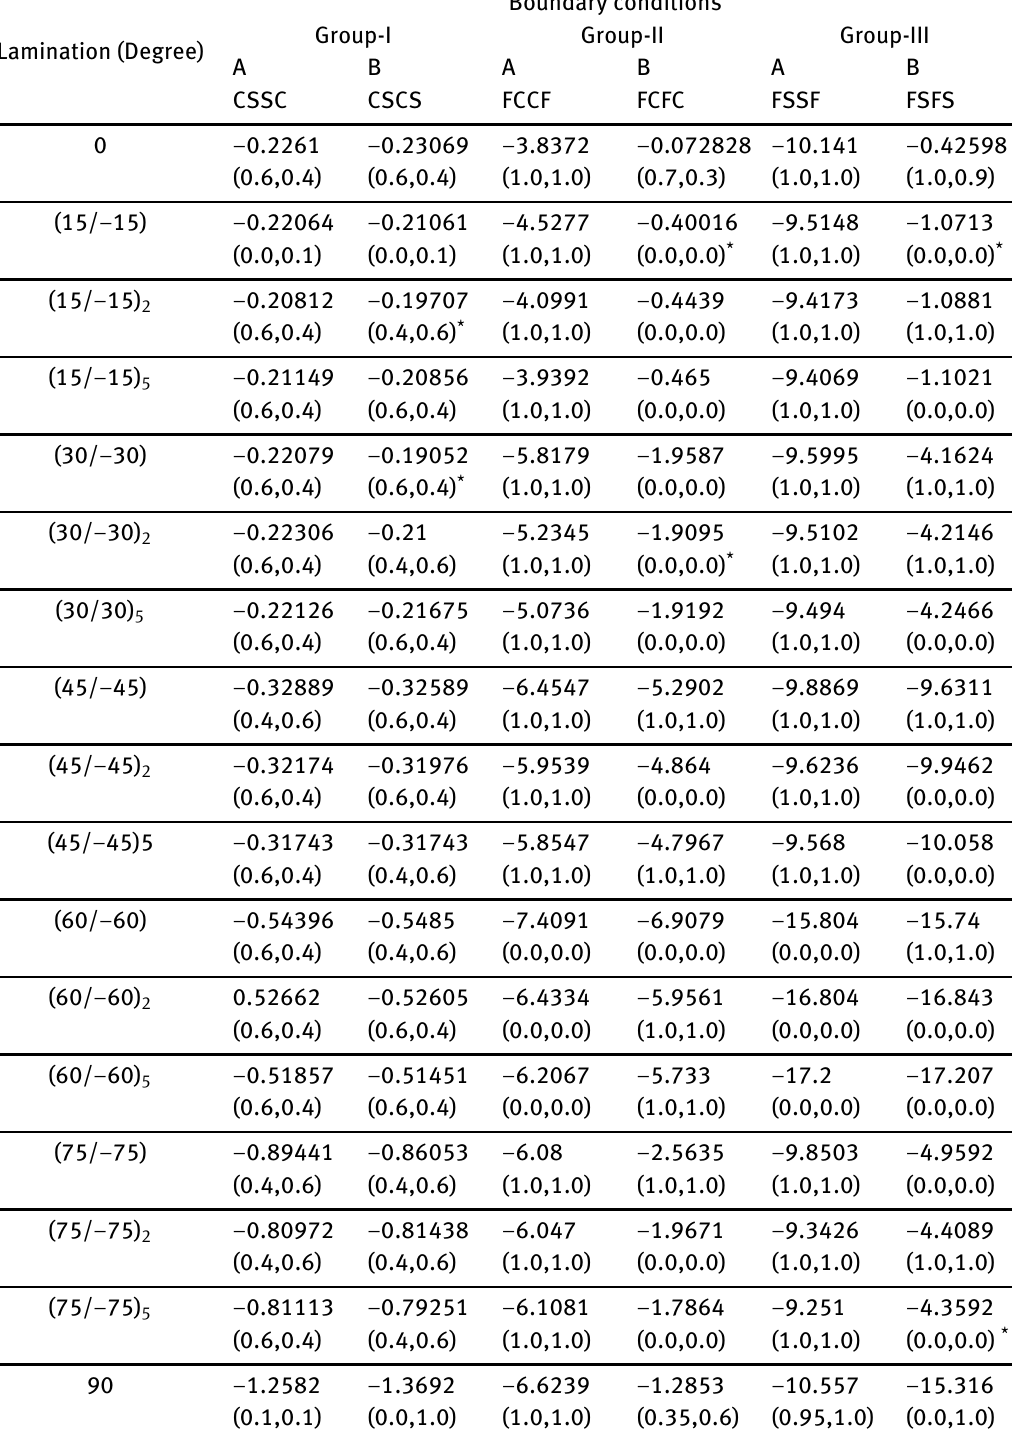
Table 5: Values of maximum non-dimensional compressive in-plane forces (− N x ) for different antisymmetric angle ply lamination and boundary conditions of stiffened composite hypar shell with